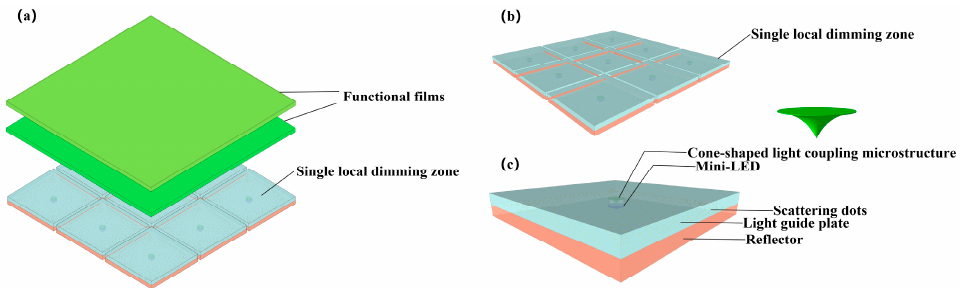
Figure 1. Schematic of ( a ) a zero-optical-distance mini-LED backlight with cone-shaped light coupling microstructures, ( b ) a mini-LED backlight module with nine local dimming zones, and ( c ) a single local dimming zone.